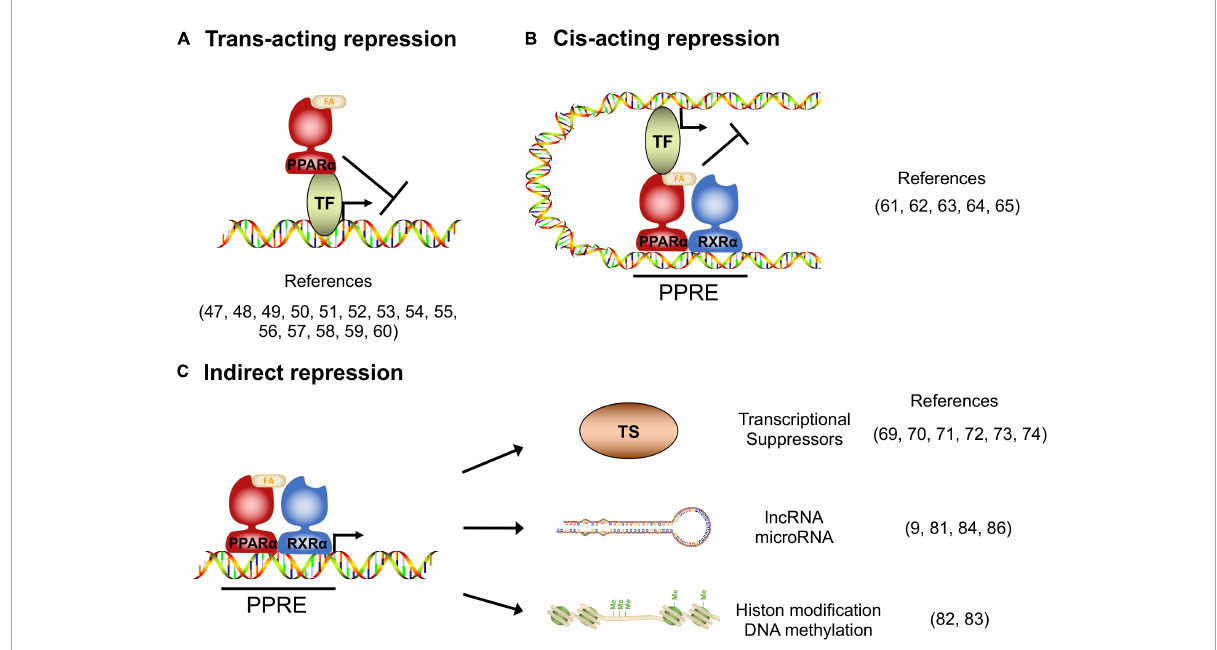
FIGURE1 Transcriptional repression manners by PPAR α . (A) Trans- acting repression manner by direct interaction between PPAR α and the target transcription factors (TF). (B) Cis -acting repression manner depending on PPAR α binding to the PPAR responsive element (PPRE). (C) Indirect repression manner, upregulating transcriptional suppressors, long non-coding RNAs, microRNAs and epigenetic